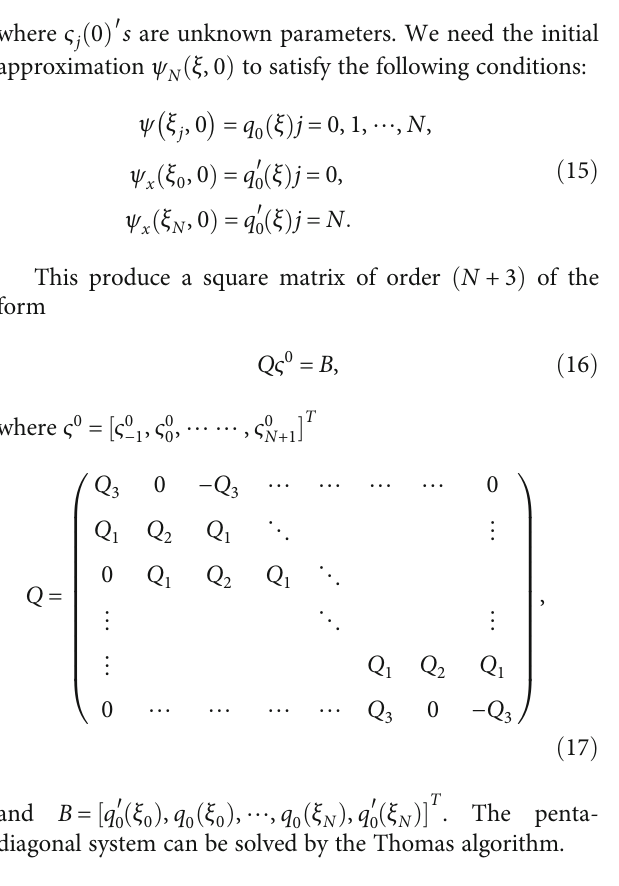
with N = 50 and α 1 = 0 : 2 , α 2 = 0 : 8 . f = 0 : f